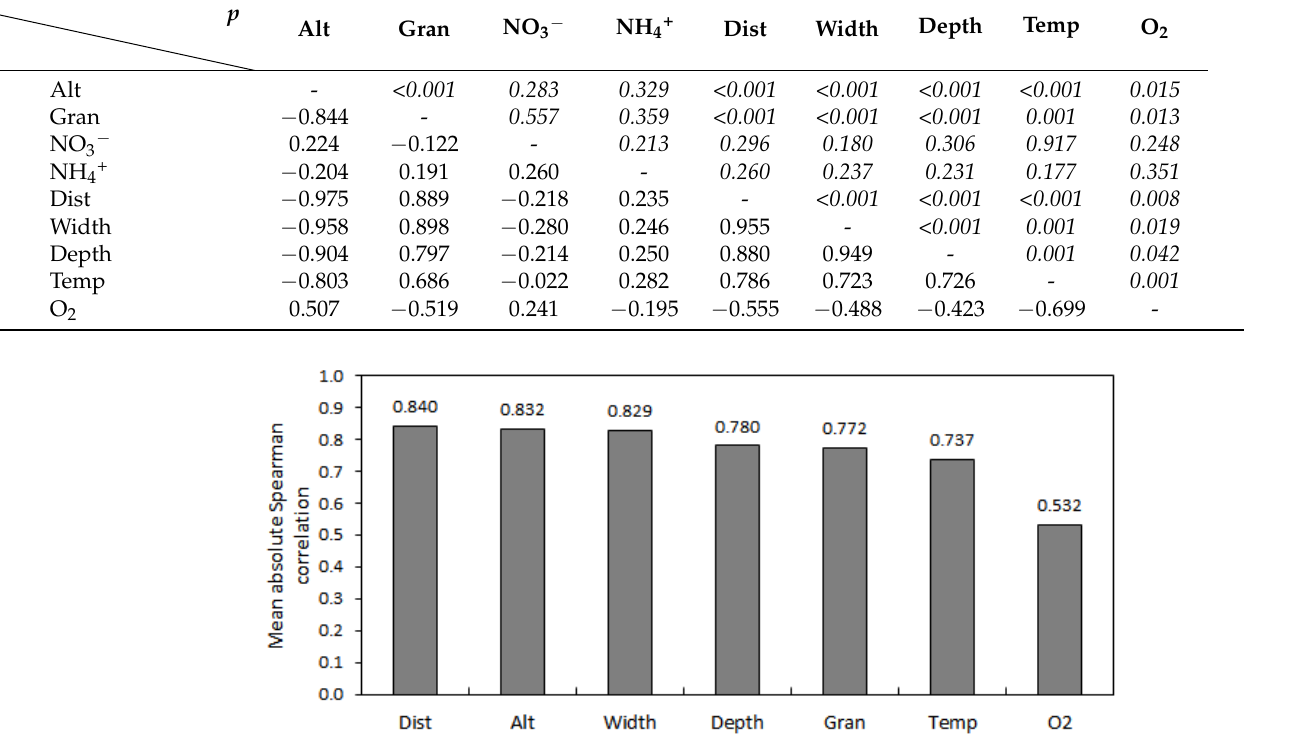
Figure 2. Mean absolute spearman correlation of each parameter with all the rest (NO 3 − and NH 4+ correlations with parameters on the graph are excluded ) .